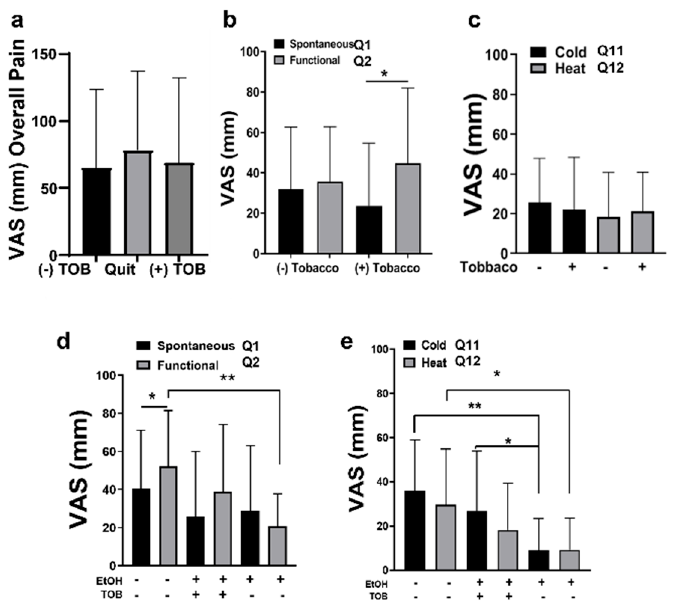
Figure 7. ( a ) VAS score for overall pain (Q1 + Q2) in subjects with a history of tobacco, who had quit tobacco, and who were currently using tobacco. ( b ) VAS scores for spontaneous pain (Q1) and func- tional pain (Q2) (+/-) smoking tobacco. ( c ) VAS scores for cold and heat allodynia (+/-) smoking to- bacco. ( d ) VAS scores for spontaneous pain (Q1) and functional pain (Q2) vs. smoking tobacco and EtOH consumption (+/-). ( e ) VAS scores for cold and heat allodynia vs. smoking tobacco and EtOH consumption. * p < 0.05 and ** p < 0.01.